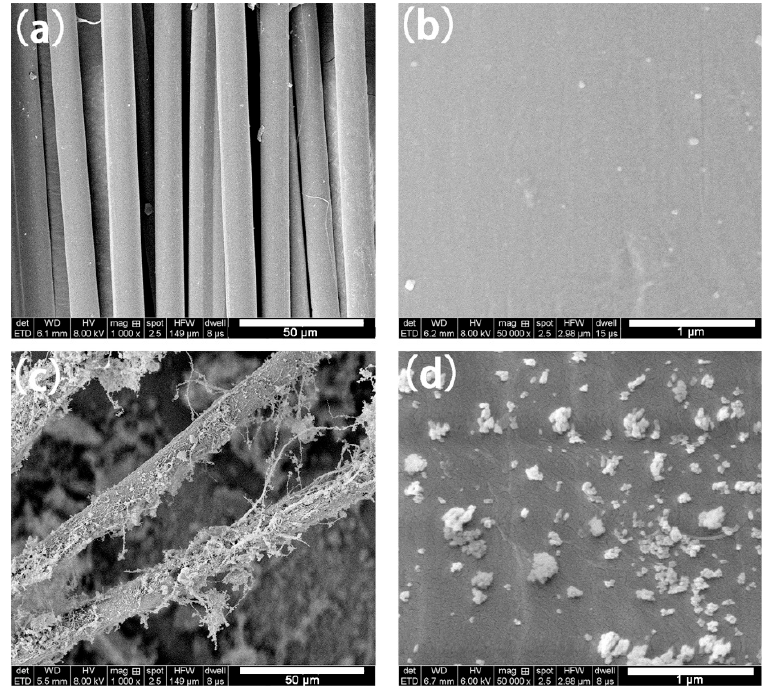
Figure 5. SEM images of ( a , b ) neat AF and ( c , d ) SiO 2 @AF.